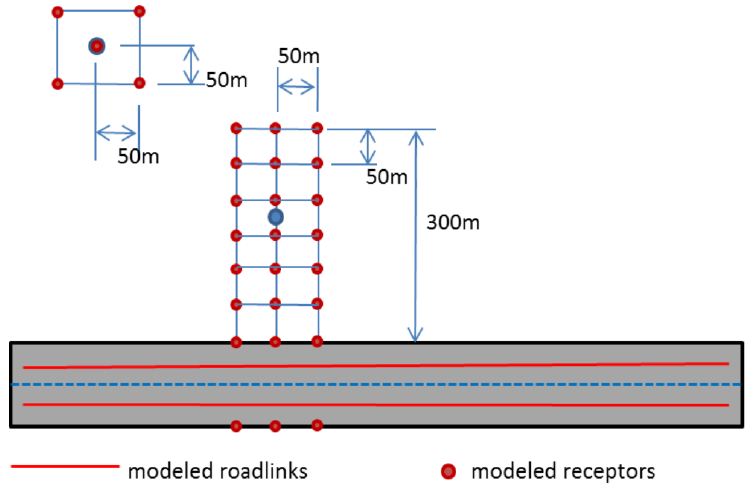
Figure 2. Model receptors near roadways: 24-receptor mini-grid